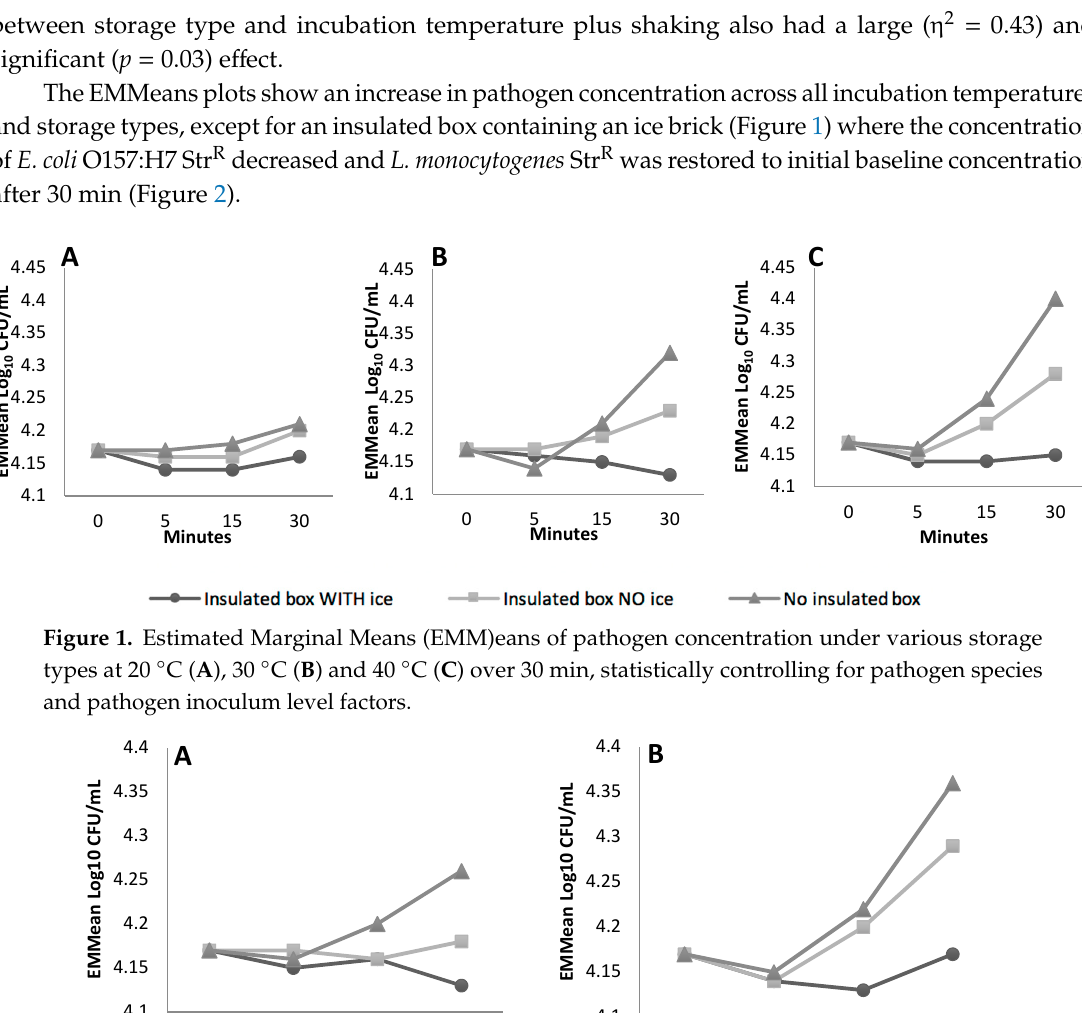
Figure 2. EMMeans of E. coli O157:H7 ( A ) and L. monocytogenes ( B ) concentrations under various storage types over 30 min, statistically controlling for shaker incubation temperature and pathogen inoculum level factors.